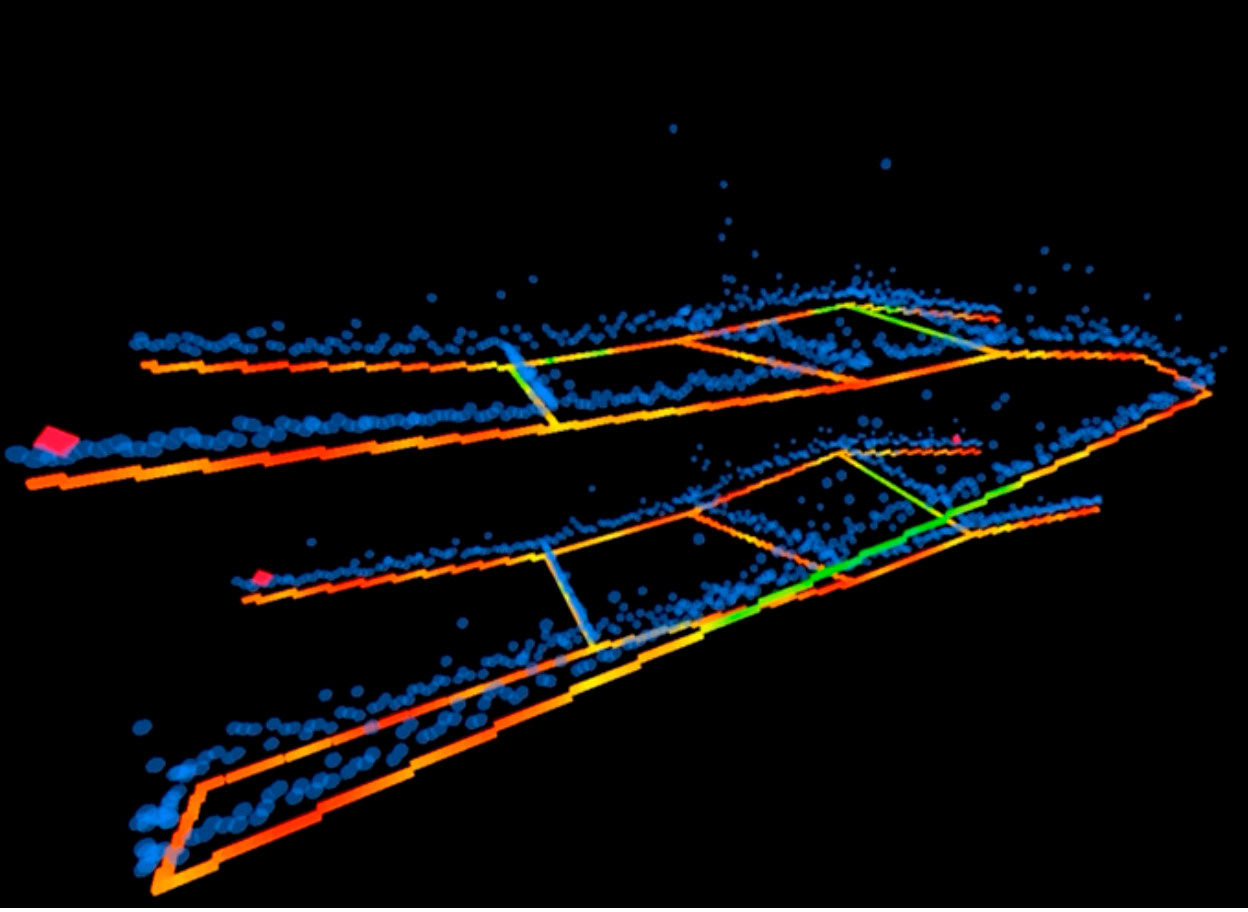
Figure A3. Screenshot of 3D visualization tool showing RSSI (multicolored solid voxels) and OWD (pale blue orbs). The moving vehicles are illustrated with red diamond shapes.